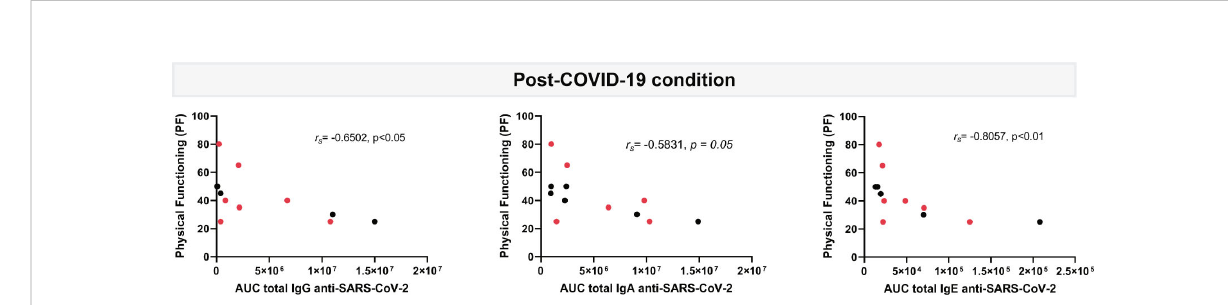
FIGURE 5 Correlation analysis of plasma circulating anti-SARS-CoV-2 IgG, IgA and IgE levels with physical functioning score from SF-36 questionnaire. Levels of IgG, IgA and IgE against the SARS-CoV-2 nucleocapsid and spike (total) are shown as the mean of the area under the curve (AUC) according to electropherograms and its correlation analyzed in post-COVID-19 condition (n=12) samples by Spearman. Samples positive for HERV-W ENV protein antigenemia are labeled in